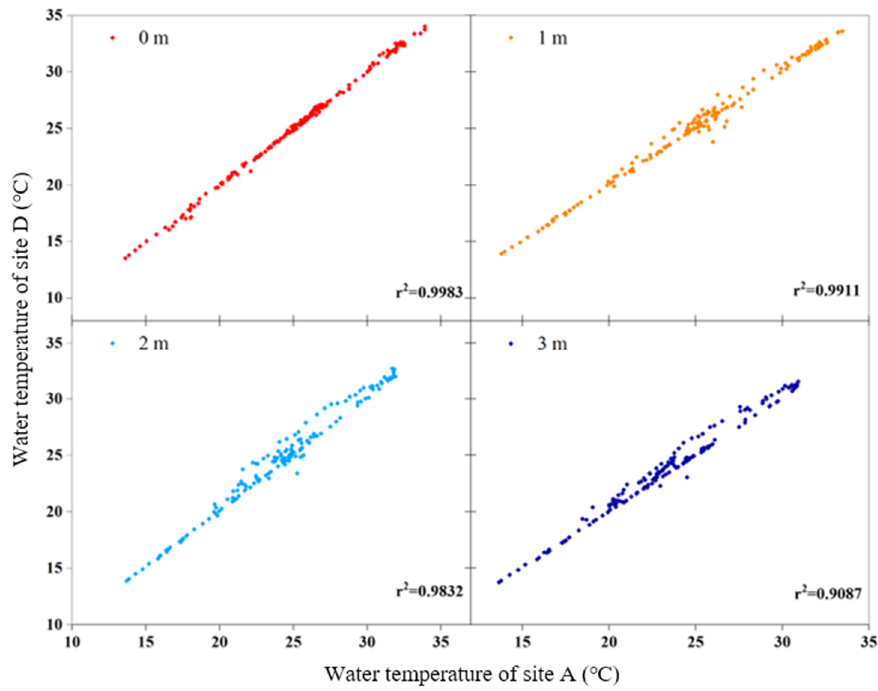
Figure 7. Correlation between the water temperature at the CWCS deployment site (site A) and the site with natural flow (site D) at various depths.